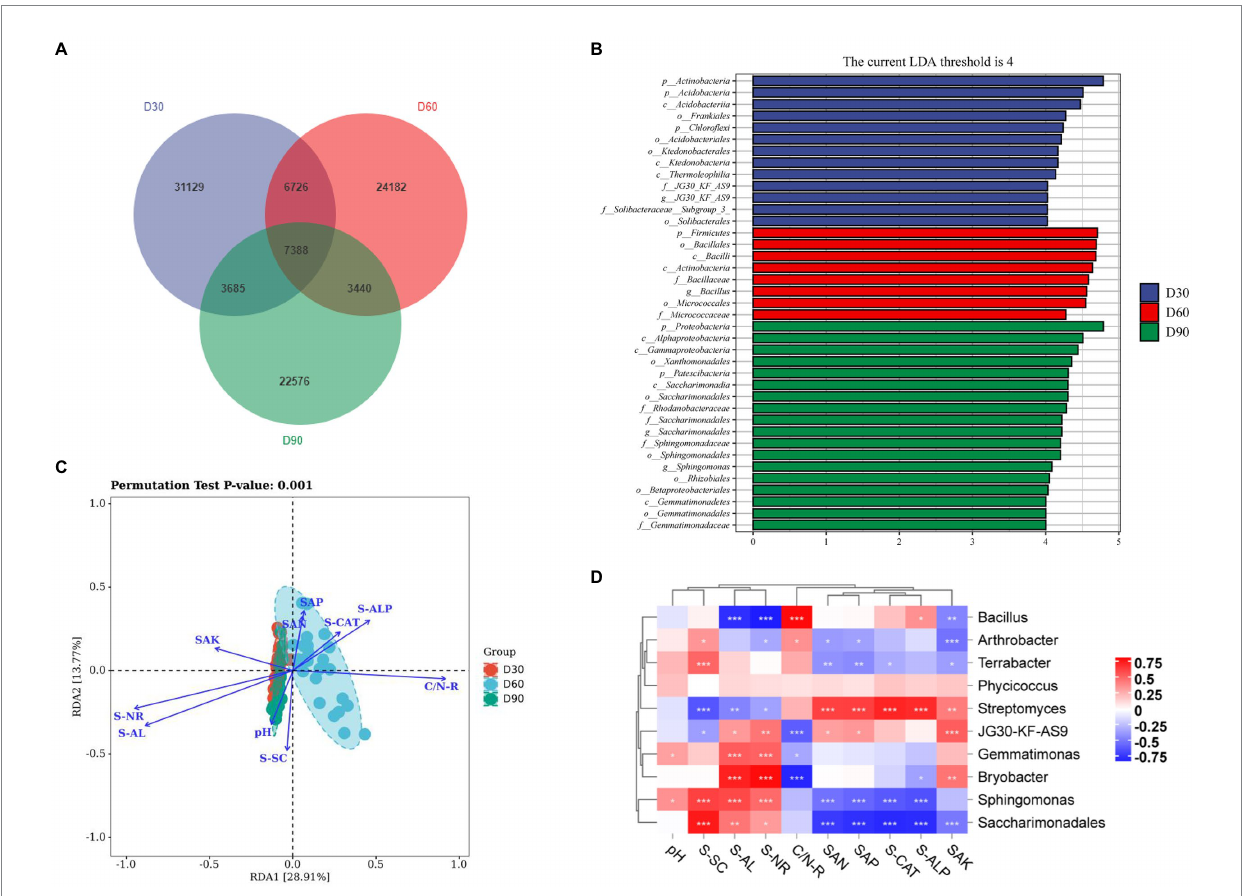
FIGURE 3 Species differences and marker species of the rhizosphere microbiota of flue-cured tobacco at different transplantation stages. (A) . Venn diagram of the rhizosphere microbiota of flue-cured tobacco. (B) . LEfSe analysis of rhizosphere microbiota of the flue-cured tobacco. (C) . RDA redundancy analysis between microbiota and physicochemical properties of the flue-cured tobacco rhizosphere soil. (D) . Correlation analysis between microbiota and physicochemical properties of the flue-cured tobacco rhizosphere